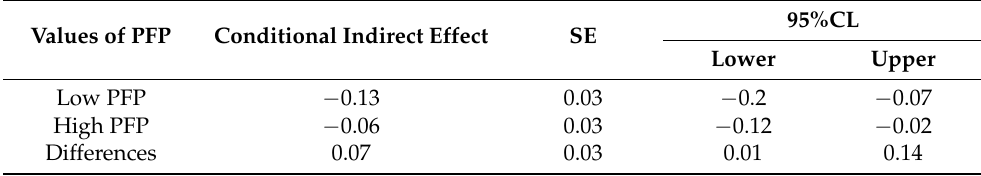
Table 6. Conditional indirect effects of POQ on creativity through emotional exhaustion at levels of PFP = M + 1 SD.